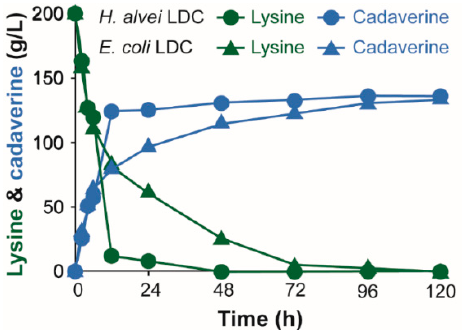
Figure 4. Time profiles of l -lysine consumption and cadaverine synthesis by recombinant E. coli XL1-Blue strain harboring E. coli ldcC gene and H. alvei ldcC genes in shake flask scale whole cell bioconversion reactions. A recombinant E. coli strains seed inoculum (OD 600 = 50) was prepared as cell biocatalysts for the conversion of 200 g / L of industrial grade l -lysine to cadaverine. Data represent mean values from three independent experiments with corresponding standard deviations. (Symbols: filled circle, l -lysine concentration; open circle, cadaverine